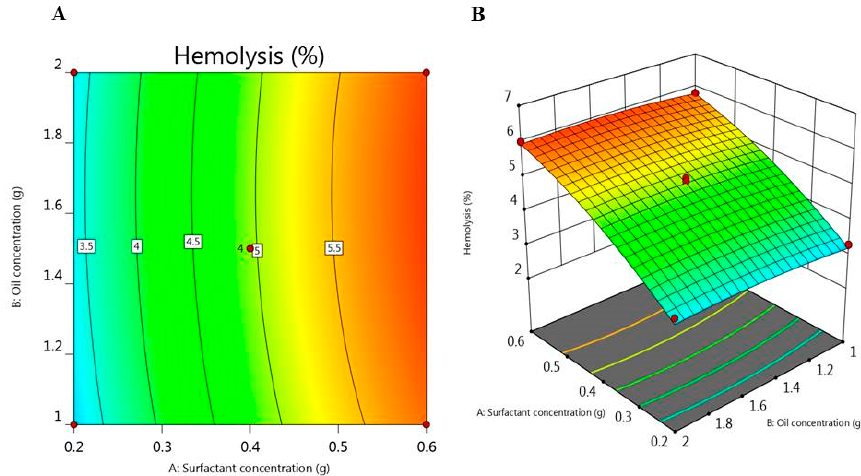
Figure 5. ( A ) 2D ‐ Contour plot and ( B ) 3D ‐ response surface plot representing the influence of sur ‐ Figure 5. ( A ) 2D-Contour plot and ( B ) 3D-response surface plot representing the influence of factant concentration (g) and oil concentration (g) on hemolysis (%). surfactant concentration (g) and oil concentration (g) on hemolysis (%).